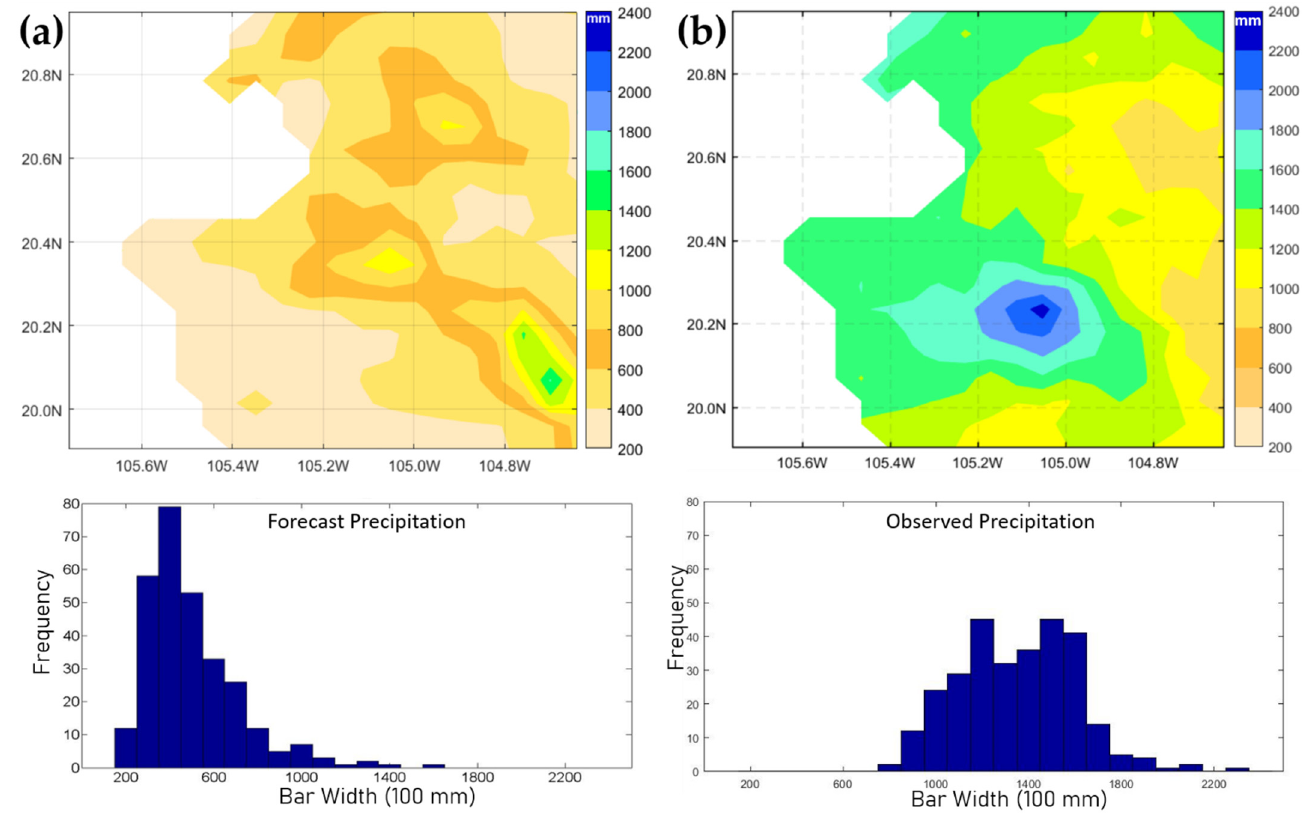
Figure 7. Distribution of the accumulated forecasted and observed precipitation with the respec- tive histograms (10 June–31 October 2010). ( a ) Distribution of accumulated forecast precipitation; ( b ) distribution of accumulated observed